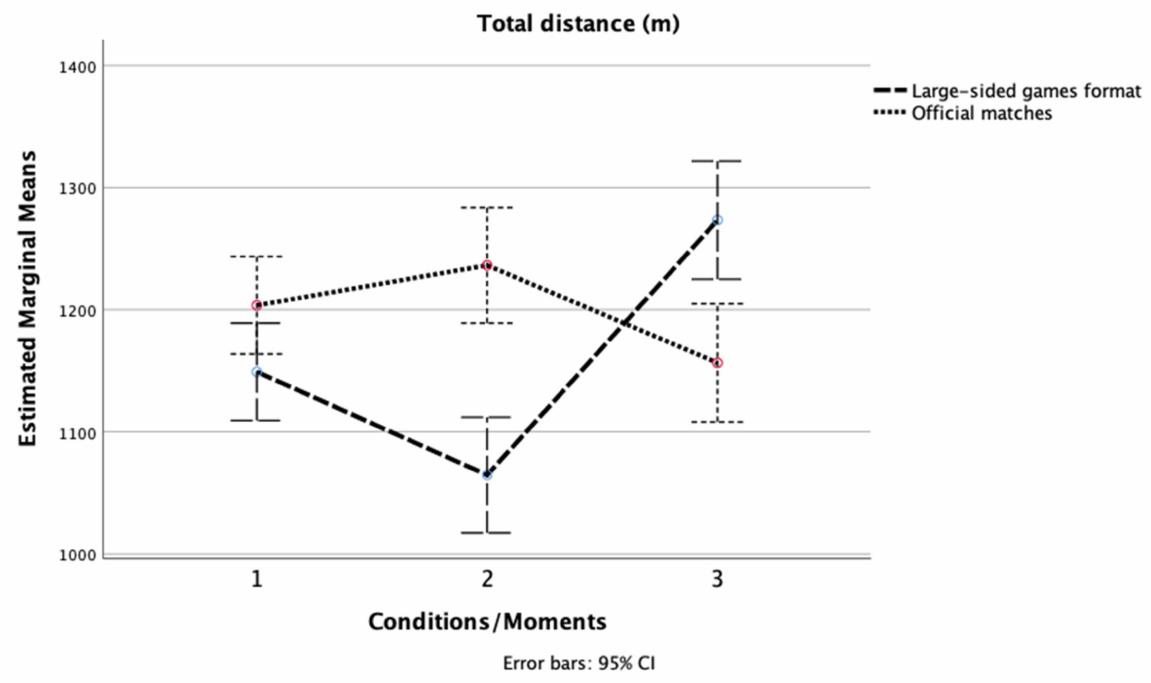
Figure 1. Changes in total distance across the three LSG formats and the three official matches.